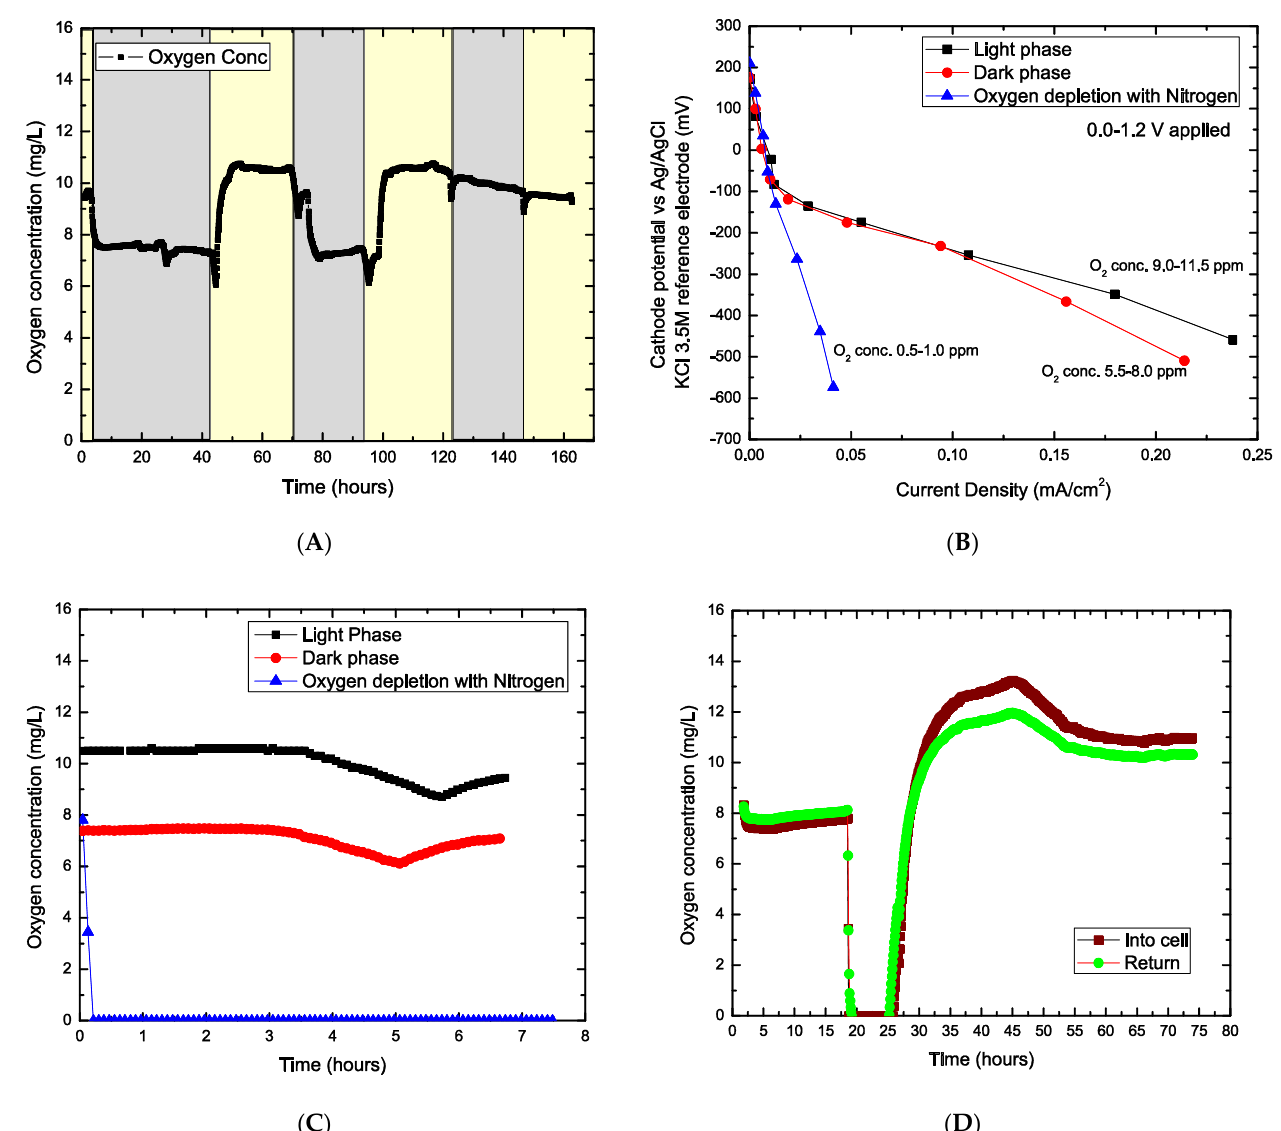
Figure 3. ( A ) Dissolved oxygen (DO) generated by microalgae in light (yellow background) and dark phase (grey background); ( B ) Cathodic behavior of algae assisted MDC under different conditions for light phase, dark phase, and O 2 depletion with N 2 , ( C ) DO concentration levels under the conditions of the light phase, dark phase and oxygen depletion and; ( D ) algae self-recovery capacity; DO before and after nitrogen gas was pumped in. NOTE: ( A ) corresponds to an independent experiment. ( B , C ) were registered simultaneously during the same experiment. Figure 3D test was carried out after experiment related to ( B , C ).